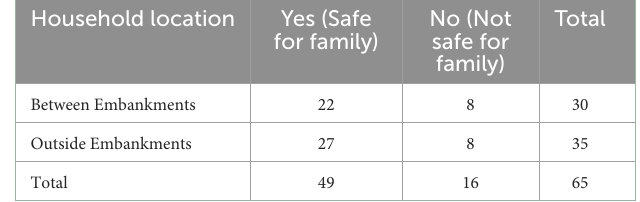
TABLE 5 Households responses on flood intensity in post embankment period. Household location